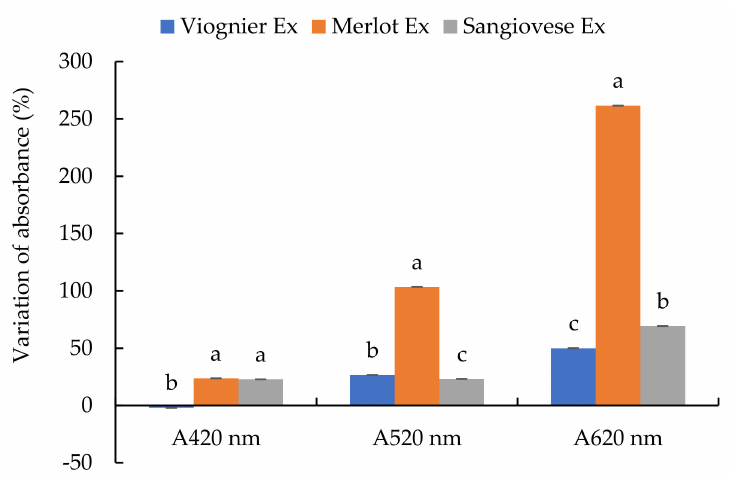
Figure 9. Percentage variation of absorbance at 420, 520 and 620 nm of a white wine after the addition of the UG extracts at a ratio of 400 mg/L. Values are the mean ± SD ( n = 3). Bars represent standard error. Different letters indicate significantly different values among the samples ( p <